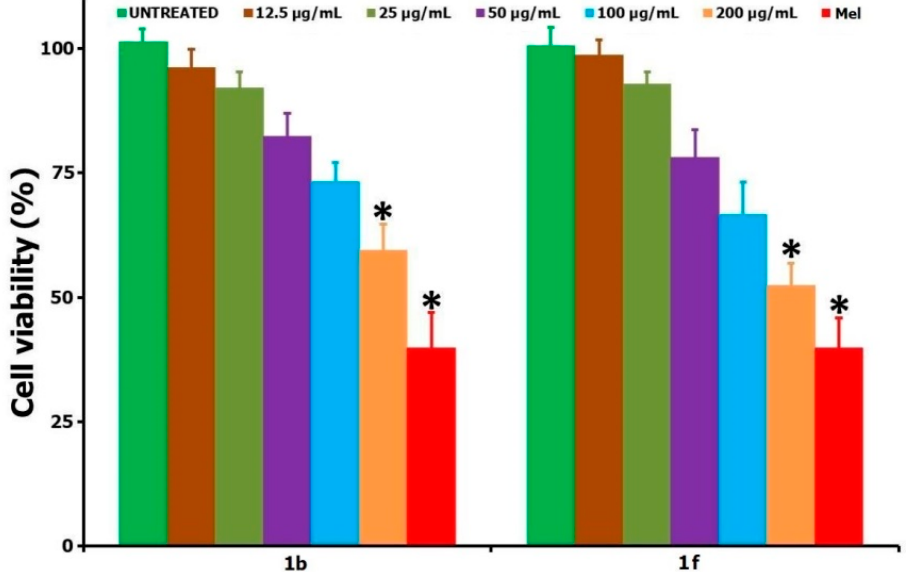
Figure 4. The percentage viability of L929 noncancer cells, followed by the treatment of compounds 1b and 1f at concentrations in the range of 12.5–200 µ g / mL (48 h period). Positive control of Mel (15 µ g / mL) and negative control of cells without any treatment were applied. * corresponds to significant ( p < 0.05) values against the untreated control.